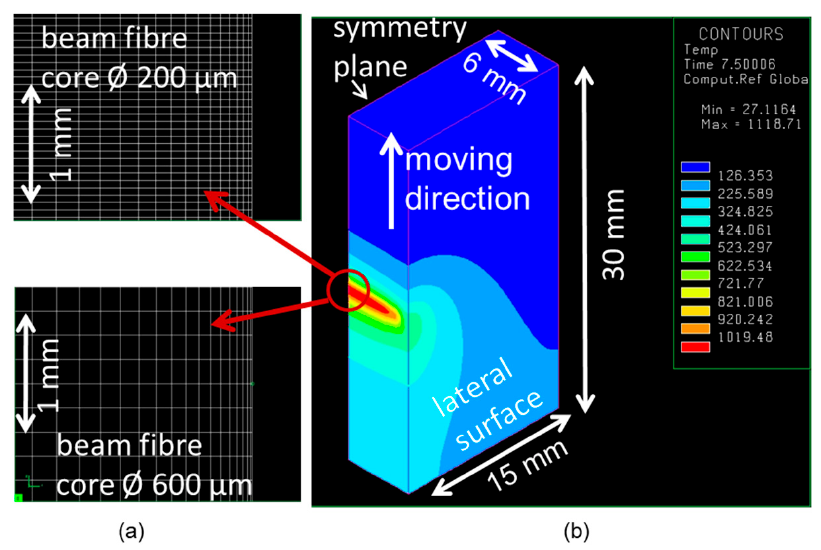
Figure 6. ( a ) FE meshes for the simulations depending on beam fiber core diameter. ( b ) Simulated temperature distribution at the surface.